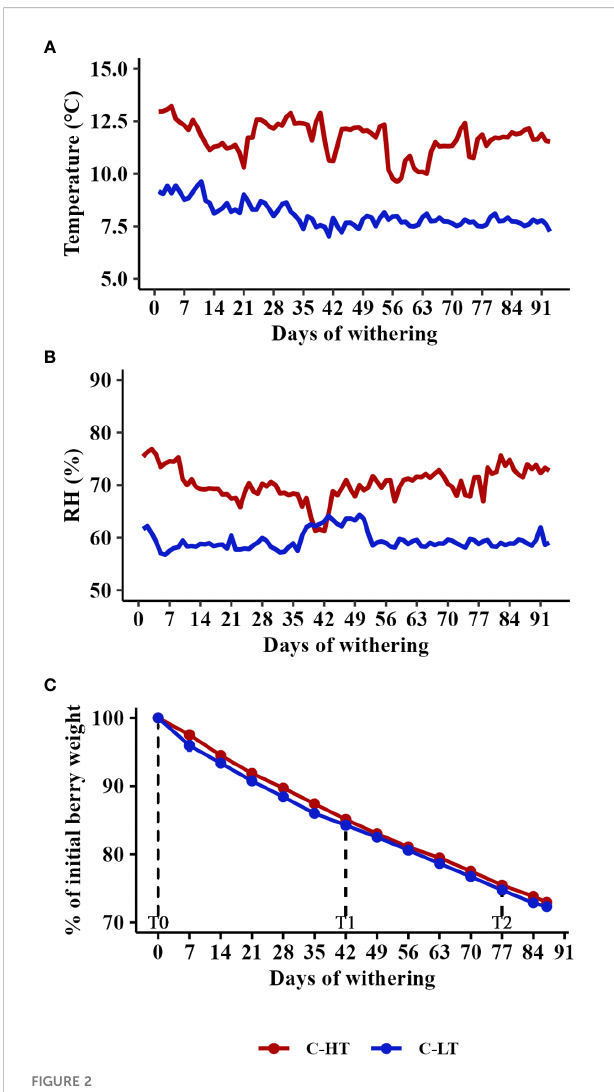
FIGURE 2 Postharvest dehydration in the thermo-hygrometrically controlled rooms. (A) Temperature and (B) Relative humidity (RH) in the C-HT and C-LT rooms during withering. (C) Weight loss kinetics of berries during withering in the C-HT and C-LT rooms reported as mean value ± SD of three biological replicates. For technological, metabolic and molecular analyses, grapes were collected during the withering processes at signed sampling time points corresponding to harvest time (T0), to ∼ 15% weight loss (T1) and to the end of withering (T2).